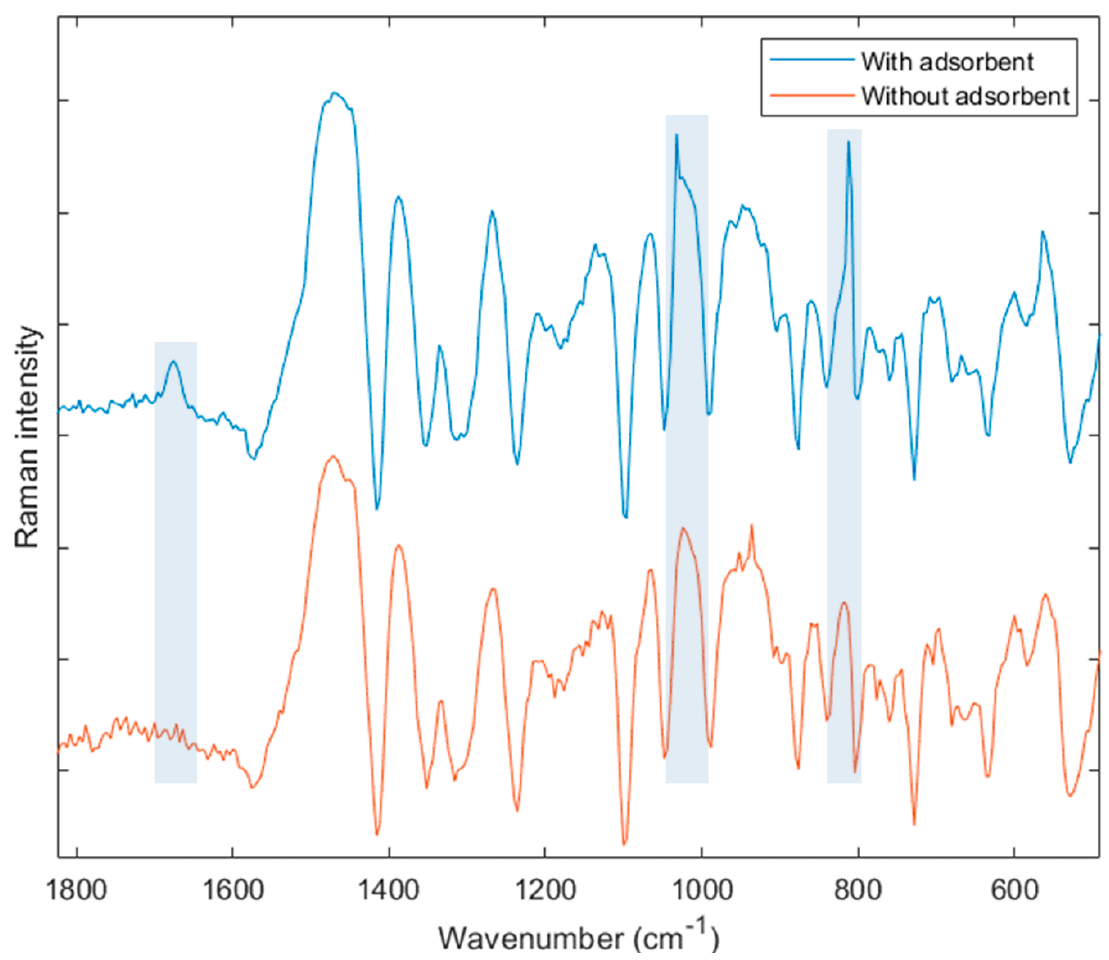
Figure 8. The e ff ect of adsorbent on SERS spectra of MeSA VOC. MeSA standard Raman spectrum is Figure 8. The effect of adsorbent on SERS spectra of MeSA VOC. MeSA standard Raman spectrum is available in the Supplementary Materials, Figure available in the Supplementary Materials, Figure S1.